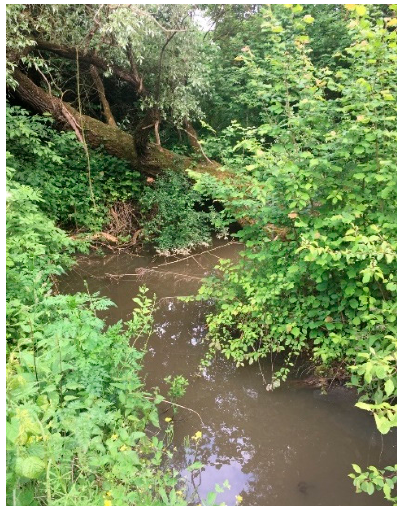
Figure 3. Dupu ş River refuge habitat. Figure 3. Dupu¸s River refuge